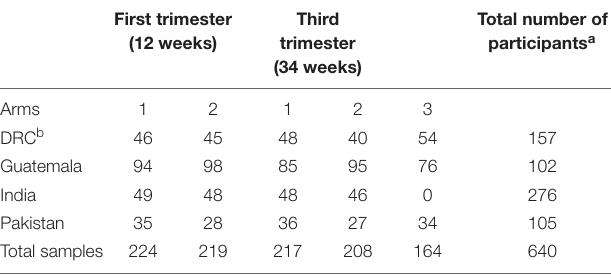
TABLE 2 | Number of microbiota samples analyzed by site, gestational time points, and supplement arms. First trimester (12 weeks)